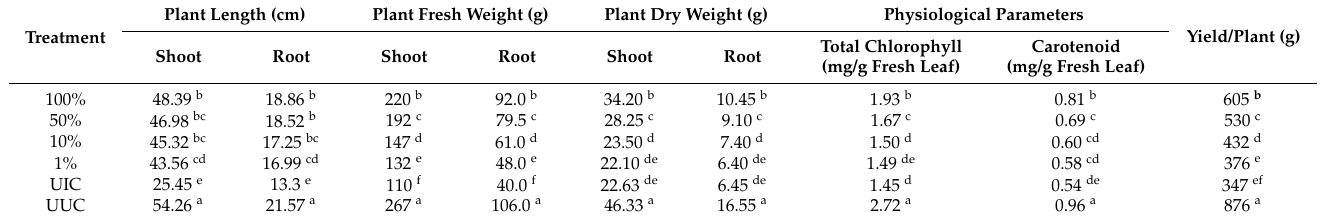
Table 7. Effect of G. lucidum CFs on the growth and physiological parameters of eggplant in relation to M. incognita